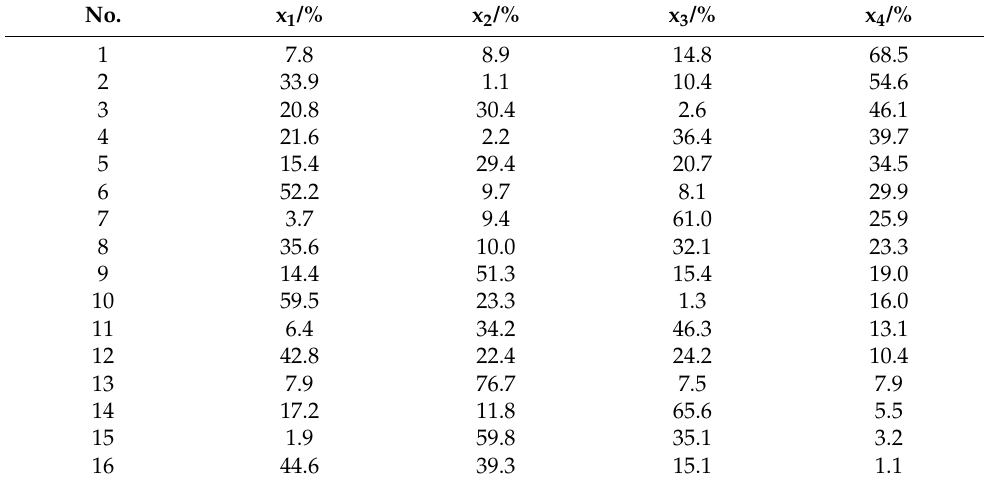
Table 2. Uniform design scheme of different lithological coarse aggregate mixtures.